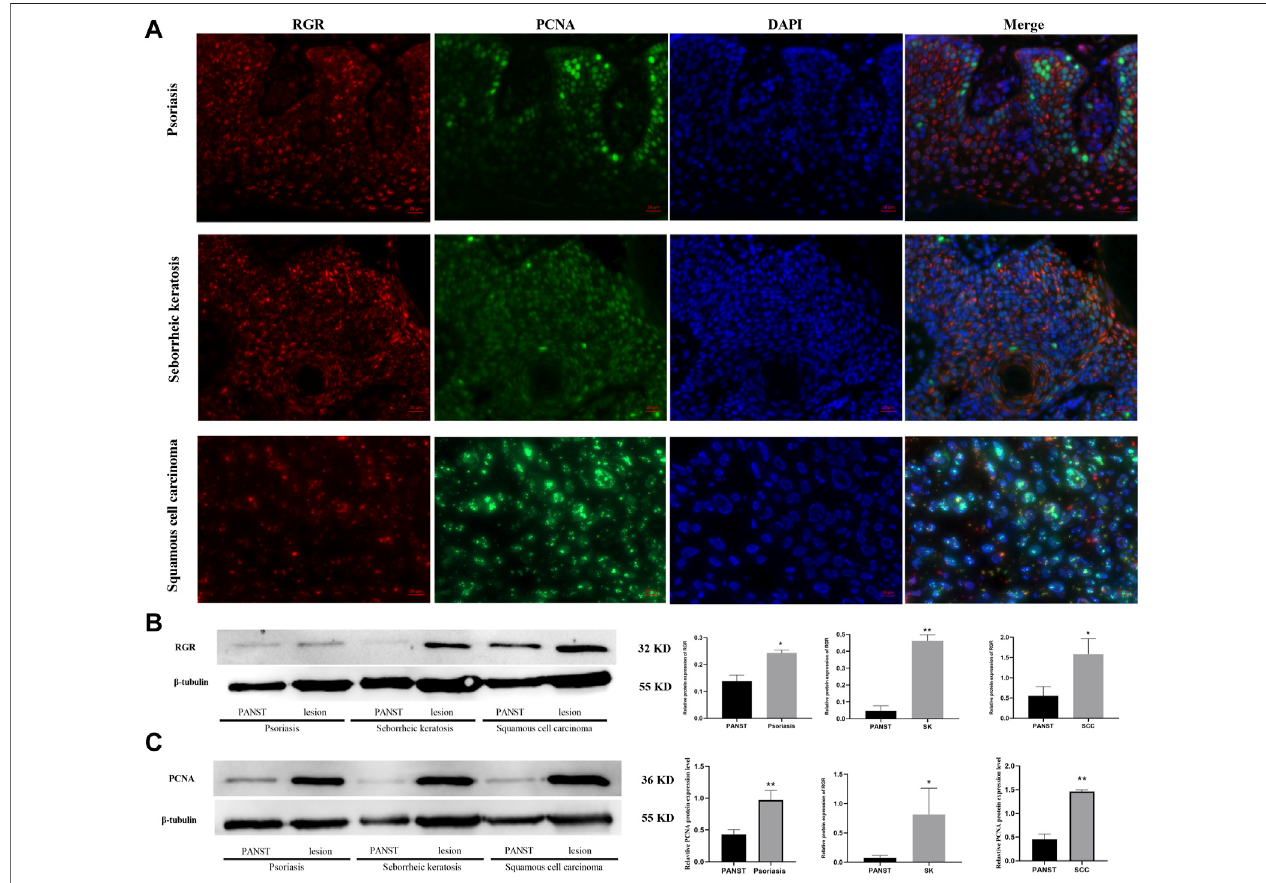
FIGURE4 | RGR ishighly expressed inproliferative diseases and tumor tissues. (A) RGR expression (red) iscolocalized with theproliferative marker PCNA (green) inpsoriasis,seborrheickeratosis,andsquamouscellcarcinoma.Scalebar=20 μ m. (B) RepresentativeexpressionofRGRand β -tubulin(loadingcontrol)inlesionareas and non-lesion areas was detected by WB analysis. The relative protein levels of RGR and β -tubulin were measured using ImageJ software (n = 3 independent experiments).* p < 0.05. (C) RepresentativeexpressionofPCNAand β -tubulin(loadingcontrol)wasdetectedbyWBanalysis.TherelativeproteinlevelsofRGRand β -tubulin were measured using ImageJ software (n = 3 independent experiments). ** p < 0.01.